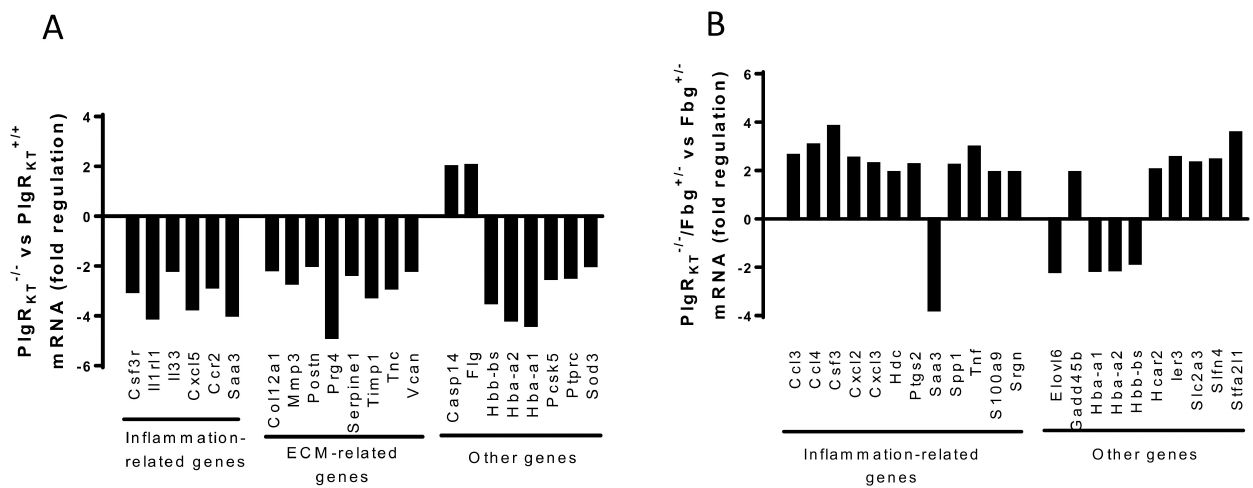
Figure 4. Effect of Plg-R KT deletion on gene expression in wound tissue. Gene expression was studied using mRNA sequencing in samples taken at day 11 ( n = 4). All the genes had corrected p -value ≤ 0.05. ( A ) Genes whose expression changed ≥ 1.5-fold in Plg-R KT − / − compared with Plg-R KT+ / + tissue. ( B ) Genes whose expression changed ≥ 1.5-fold in Plg-R KT − / − /Fibrinogen +/ − compared with Plg-R KT+/+ /Fibrinogen +/ − tissue. This figure is modified from a figure originally published in [80]. Creative common license available at: